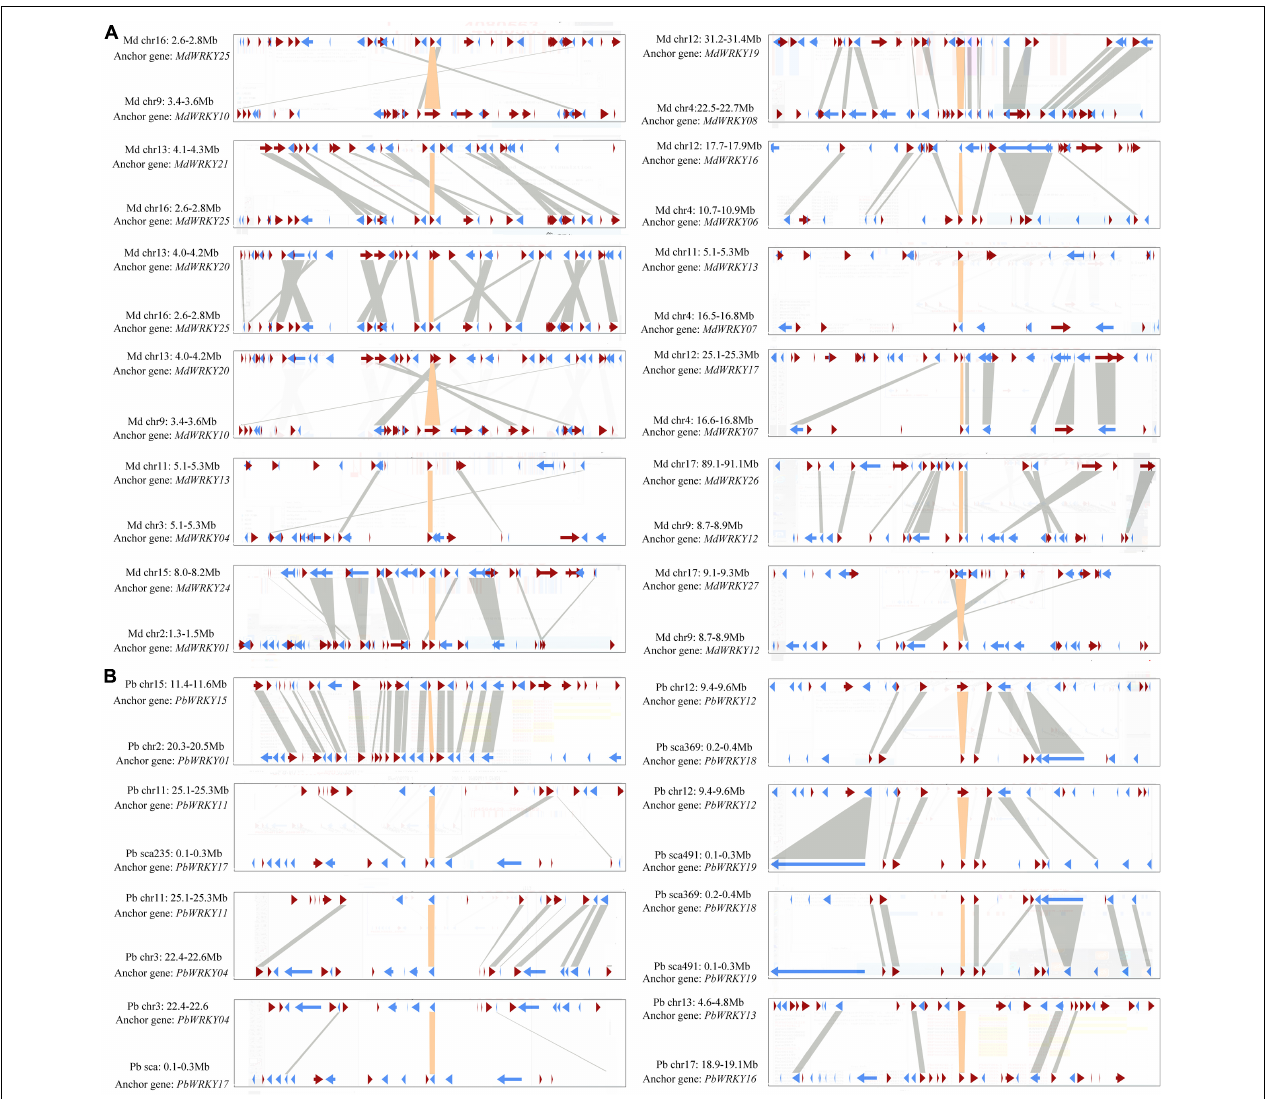
FIGURE 4 | Microsynteny maps of WRKY I genes in M. domestica (A) and P. bretschneideri (B) . The relative positions of all flanking protein-coding genes were defined by the anchored WRKY I genes, highlighted in orange. The flanking genes and their transcriptional orientations were indicated by